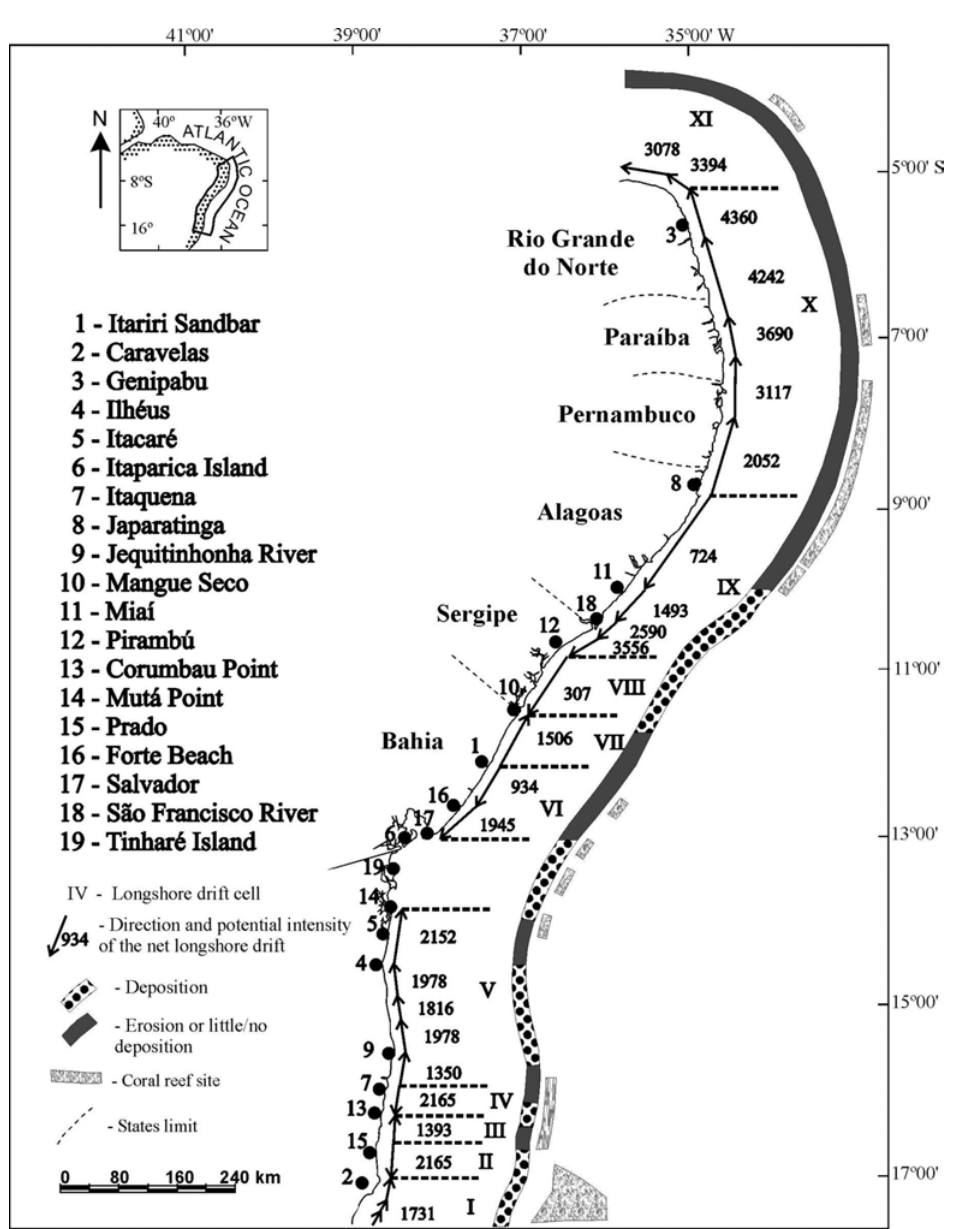
Fig. 5 – Map of northeastern and eastern Brazilian coasts showing coral reef location and longshore drift cells, and the direction and potential intensities of net longshore drift (according to Bittencourt et al.